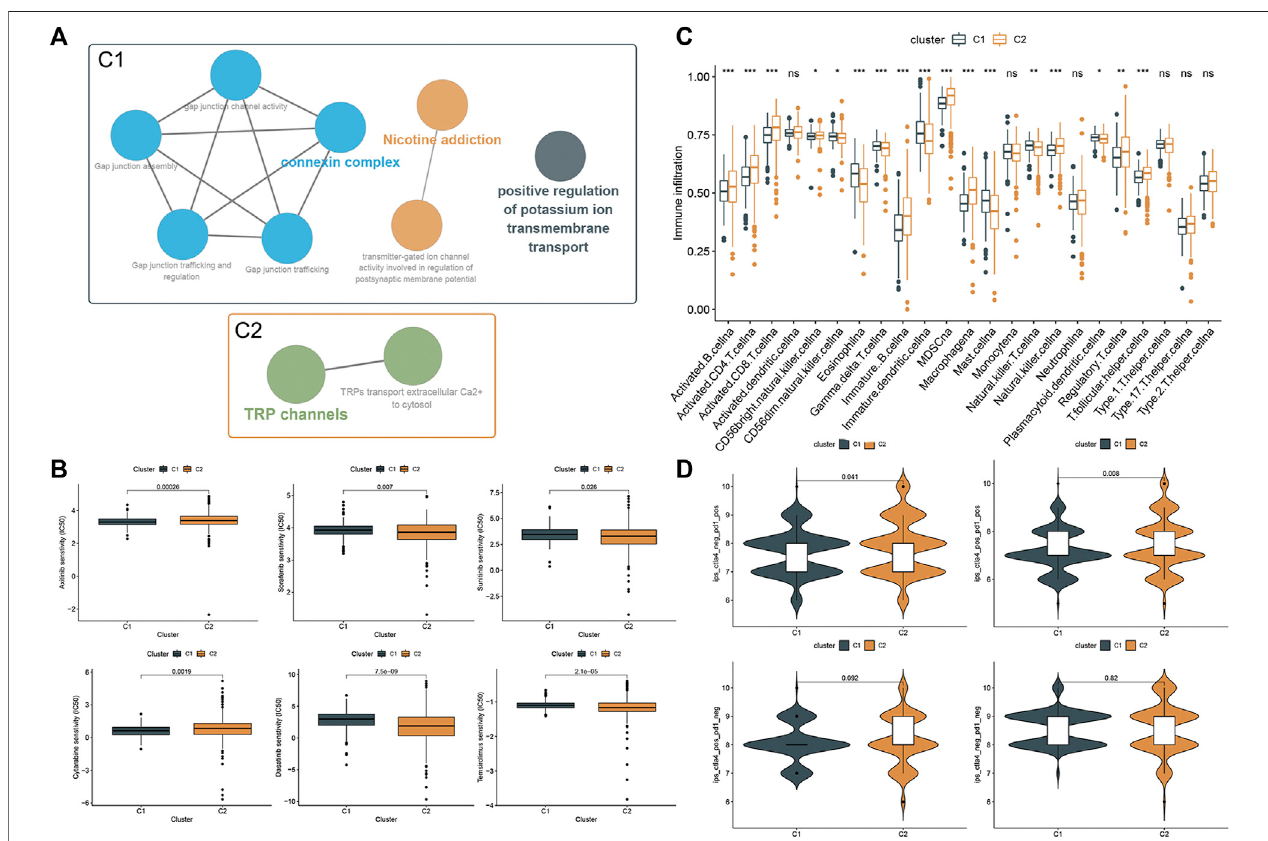
FIGURE 5 | Phenotypic differences between clusters and potential individualized treatment. (A) Biological functional annotation of differentially expressed genes between two clusters. (B) Drug sensitivity of commonly clinically used drugs for advanced ccRCC between clusters. (C) Differential analysis of immune cell in fi ltration between the twoclustersusing the ssGSEA method. (D) Relationshipbetween differences in PD-1 and CTLA-4responsiveness between the two groups, based on the TCIA database.